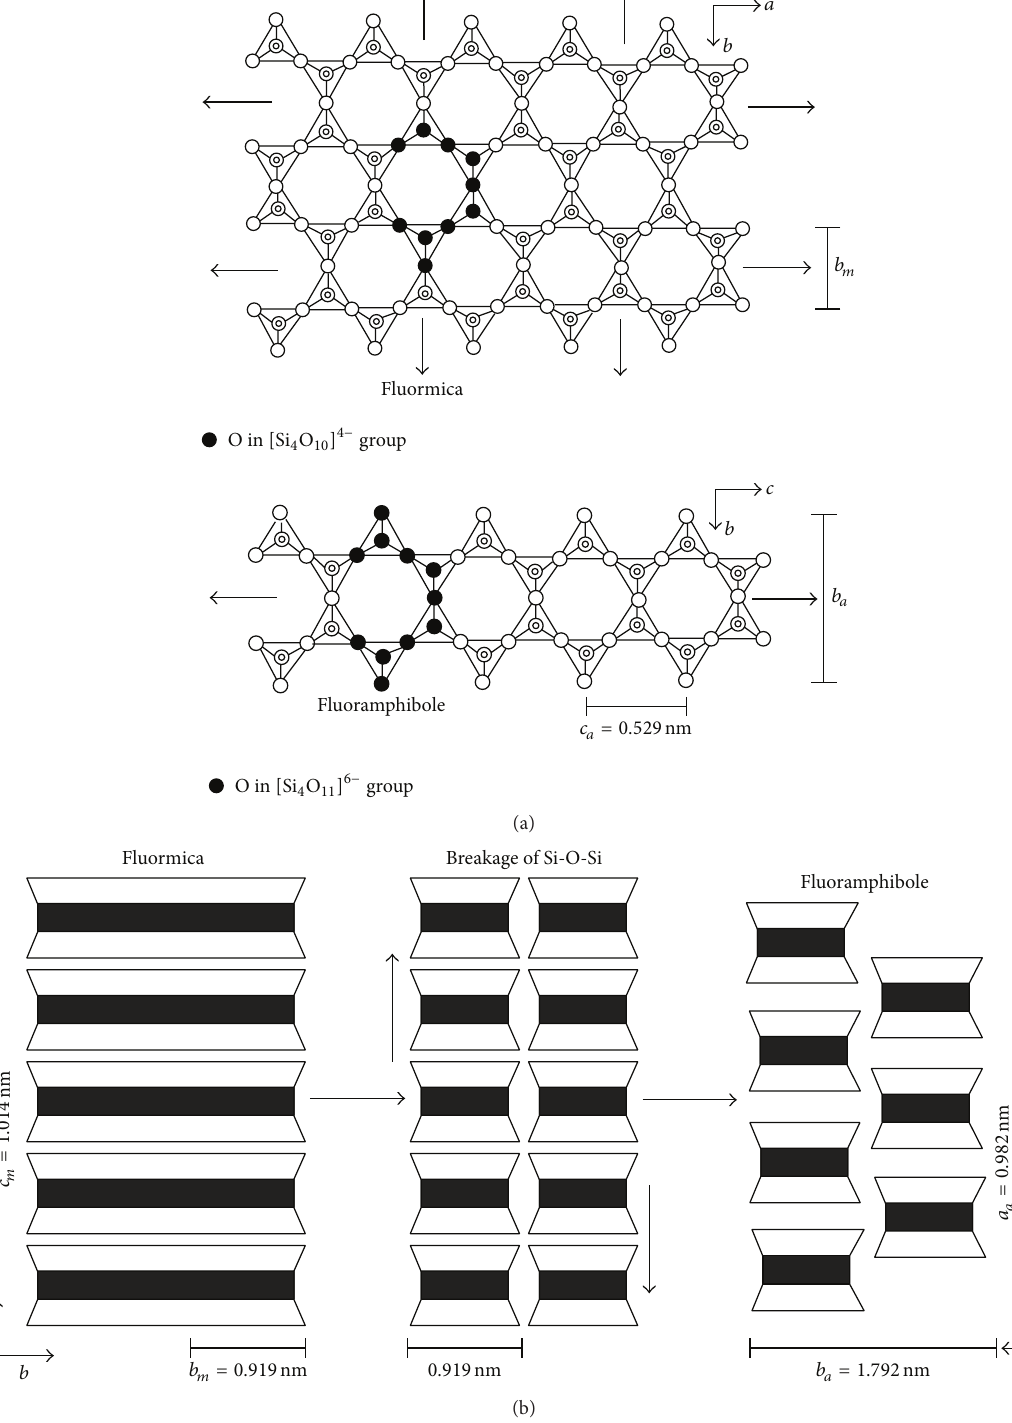
Figure 8: Schematic of transformation from fluormica to fluoramphibole. (a) The sheet and double-chain structures in fluormica and fluoramphibole. (b) Crystallography model of fluormica-fluoramphibole